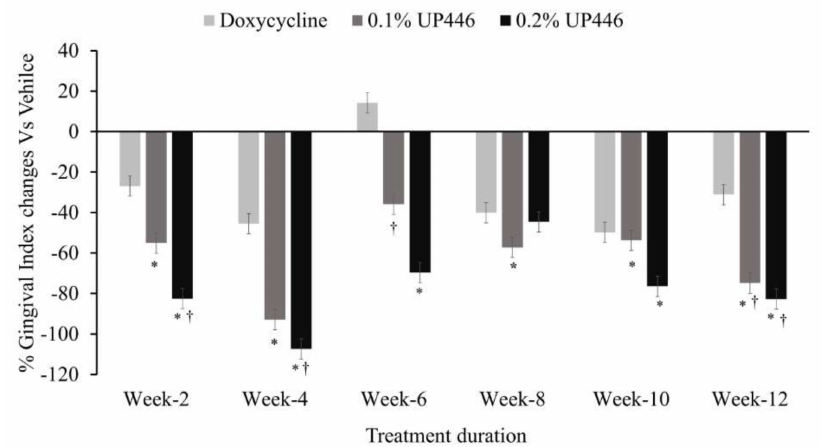
Figure 3. Changes in mean gingival indices in beagle dogs with ligature-induced periodontitis. Values are represented as di ff erences between before and after treatment. *; denote significance at p < 0.05 when compared with placebo and treated groups at the same week. † ; denote significance at p < 0.05 when compared with doxycycline and UP446 groups at the same week.